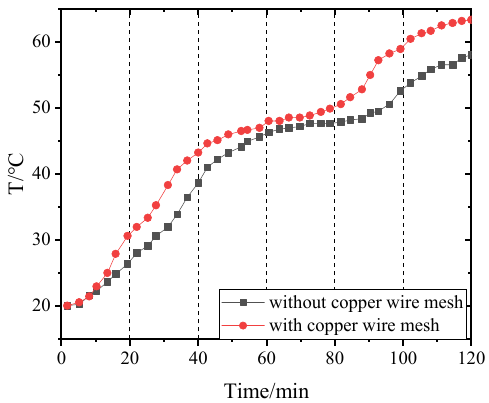
Figure 19. Temperature of point 2 in PCM-2 changing with time.